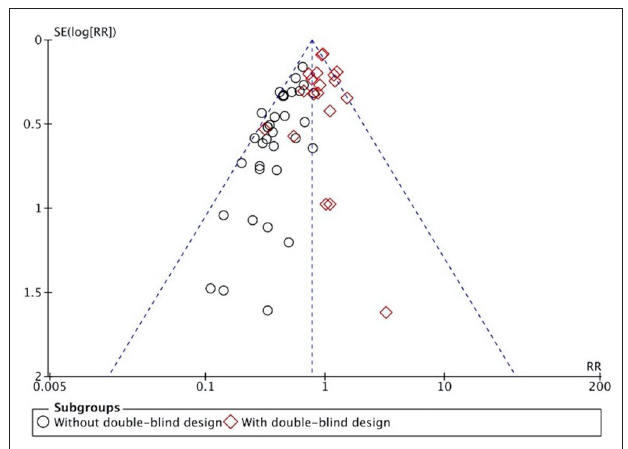
FIGURE 5 | Funnel plot indicated potential publication